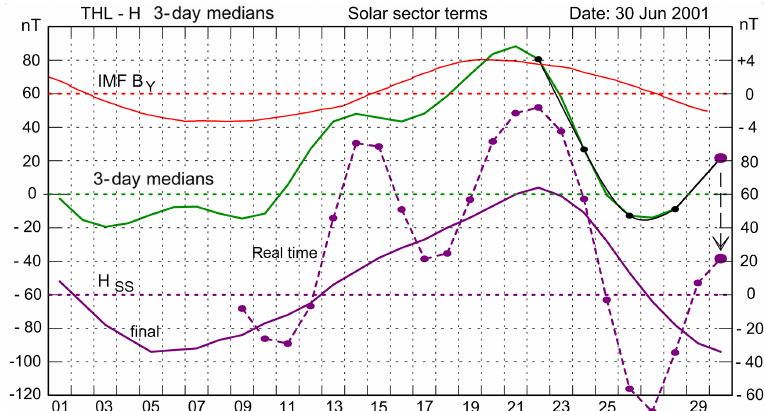
Figure 4. Calculation of H SS = 21nT for 30 June from 3-day medians from 22, 24, 26, and 28 June. The 3-day median values (from Fig. 6b of J&T2011) are shown in green line. The H SS values from Fig. 6b of J&T2011 are shown by the smooth solid magenta line on the scale to the right, while the H SS values calculated here by cubic spline extrapolation are shown on the same scale by dots connected by the dashed magenta